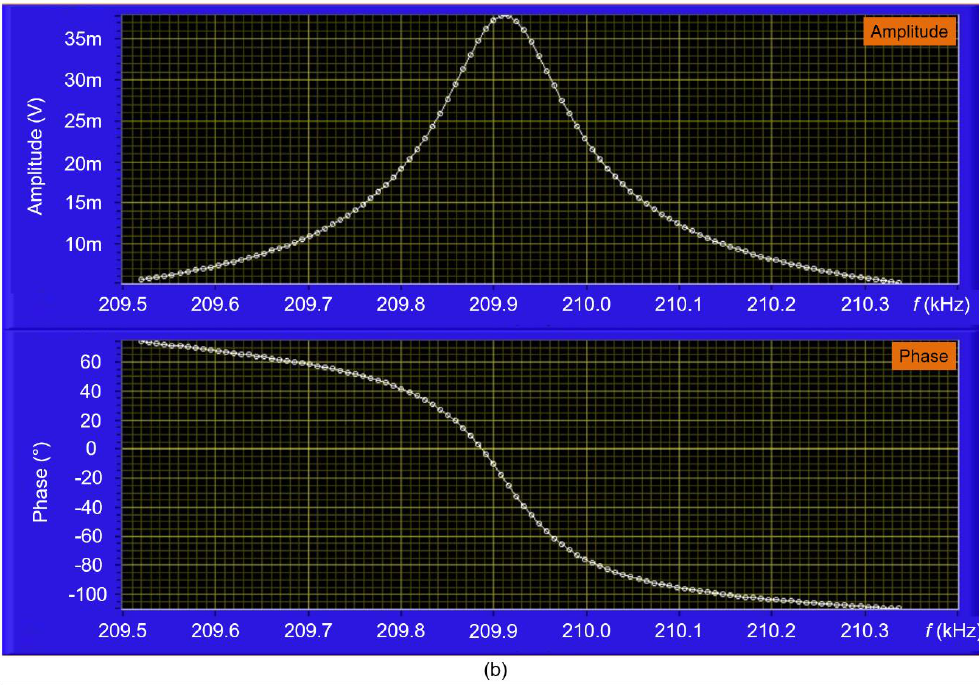
Figure 3. A LabVIEW-based user interface to execute a frequency sweep around the observed resonance mode of the EtPCS. Reference parameters of 0.43 V amplitude and 63.9 ◦ phase with the Fano resonance ( a ) are calculated to yield an optimized frequency response ( b ), i.e., a symmetrical amplitude shape and a monotonic phase transition.